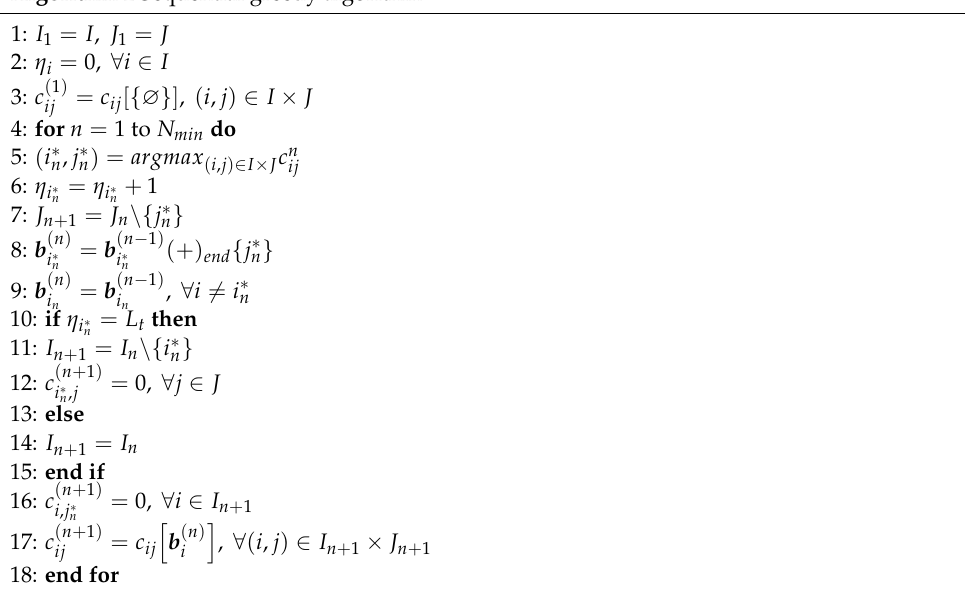
Algorithm 2 Sequential greedy algorithm